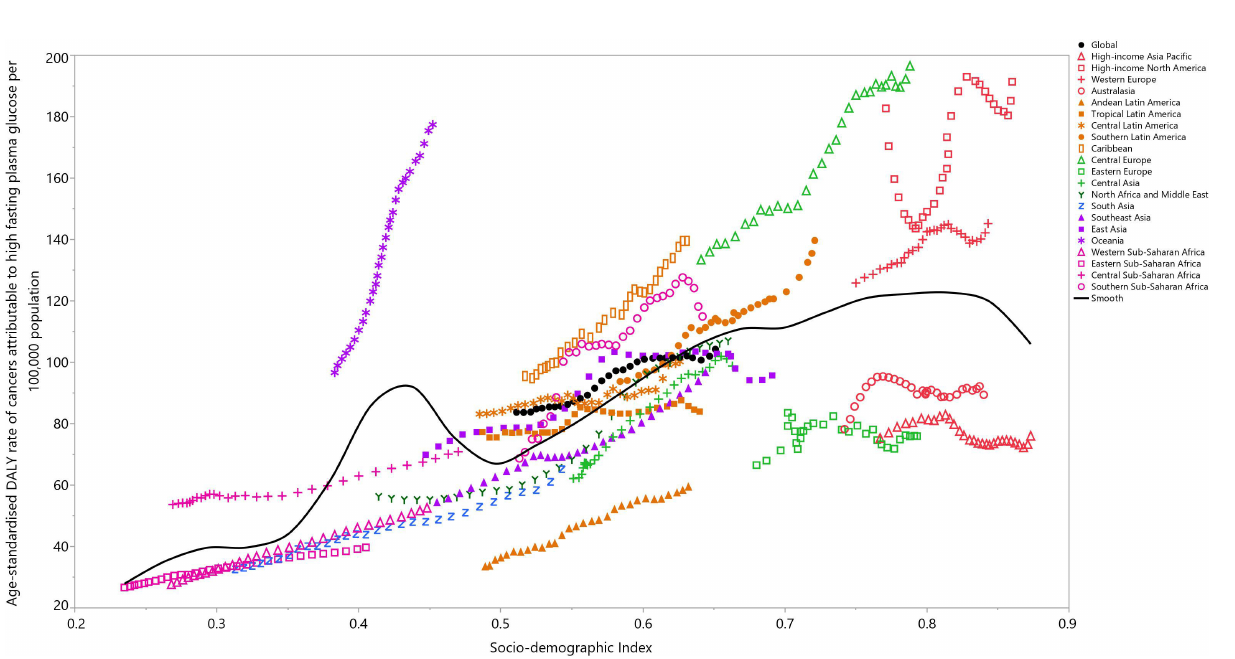
FIGURE 4 | Age-standardized DALY rates of cancers attributable to high fasting plasma glucose for the 21 Global Burden of Disease regions by Socio- demographic Index, 1990 – 2019; Expected values based on Socio-demographic Index and disease rates in all locations are shown as the black line. Thirty points are plotted for each GBD region and show the observed age-standardized DALY rates from 1990 to 2019 for that region. DALY= disability-adjusted-life-years. (Generated from data available from